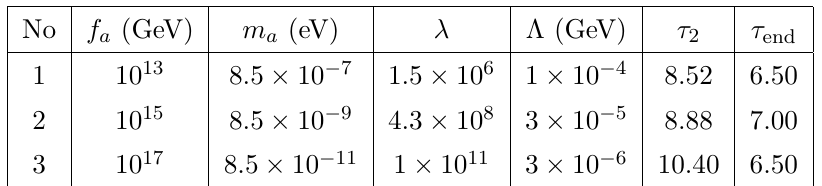
Table 2 . Sample values of { λ, Λ } that induce sufficient friction to deplete the axion relic abundance to the observed one for a given choice of { m on the SM parameters through the product m and hence we consider the entire range 10 8 GeV < f T crit